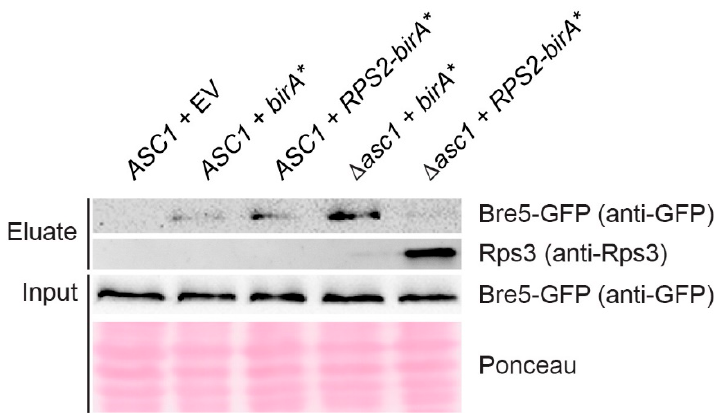
Figure 3. Immuno-detection of Bre5 and Rps3 captured with a small-scale Rps2-BirA * BioID experiment. Rps2-BirA * BioID capture was performed in a small-scale format (see Materials and Methods for details) using strains expressing GFP-tagged Bre5. BirA * and Rps2-BirA * were expressed from high copy number plasmids in ASC1 wild-type and asc1 − strains as indicated, and the ASC1 wild-type strain was additionally transformed with the empty vector (EV) as a control. Western blot experiments were performed with a GFP-antibody and an Rps3-antibody to detect protein enrichment in eluate fractions. Bre5-GFP was also detected in the total cell extracts (input). Ponceau staining of proteins served as a loading control for the input.